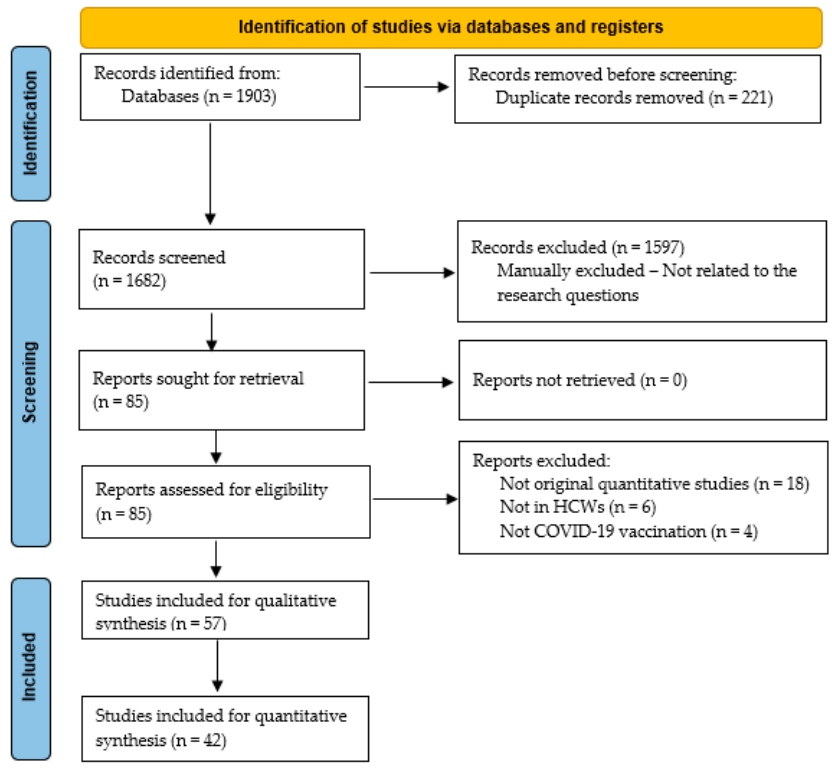
Figure 2. Flowchart of our systematic literature search (July 2022–November 2022) .